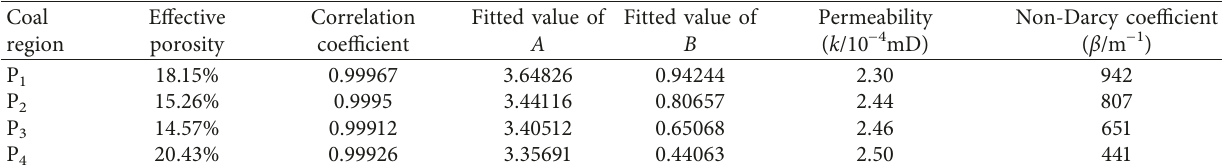
Figure 12: Variation of average seepage velocities and pressure gradient. Table 4: Coal’s permeability and non-Darcy coefficients after